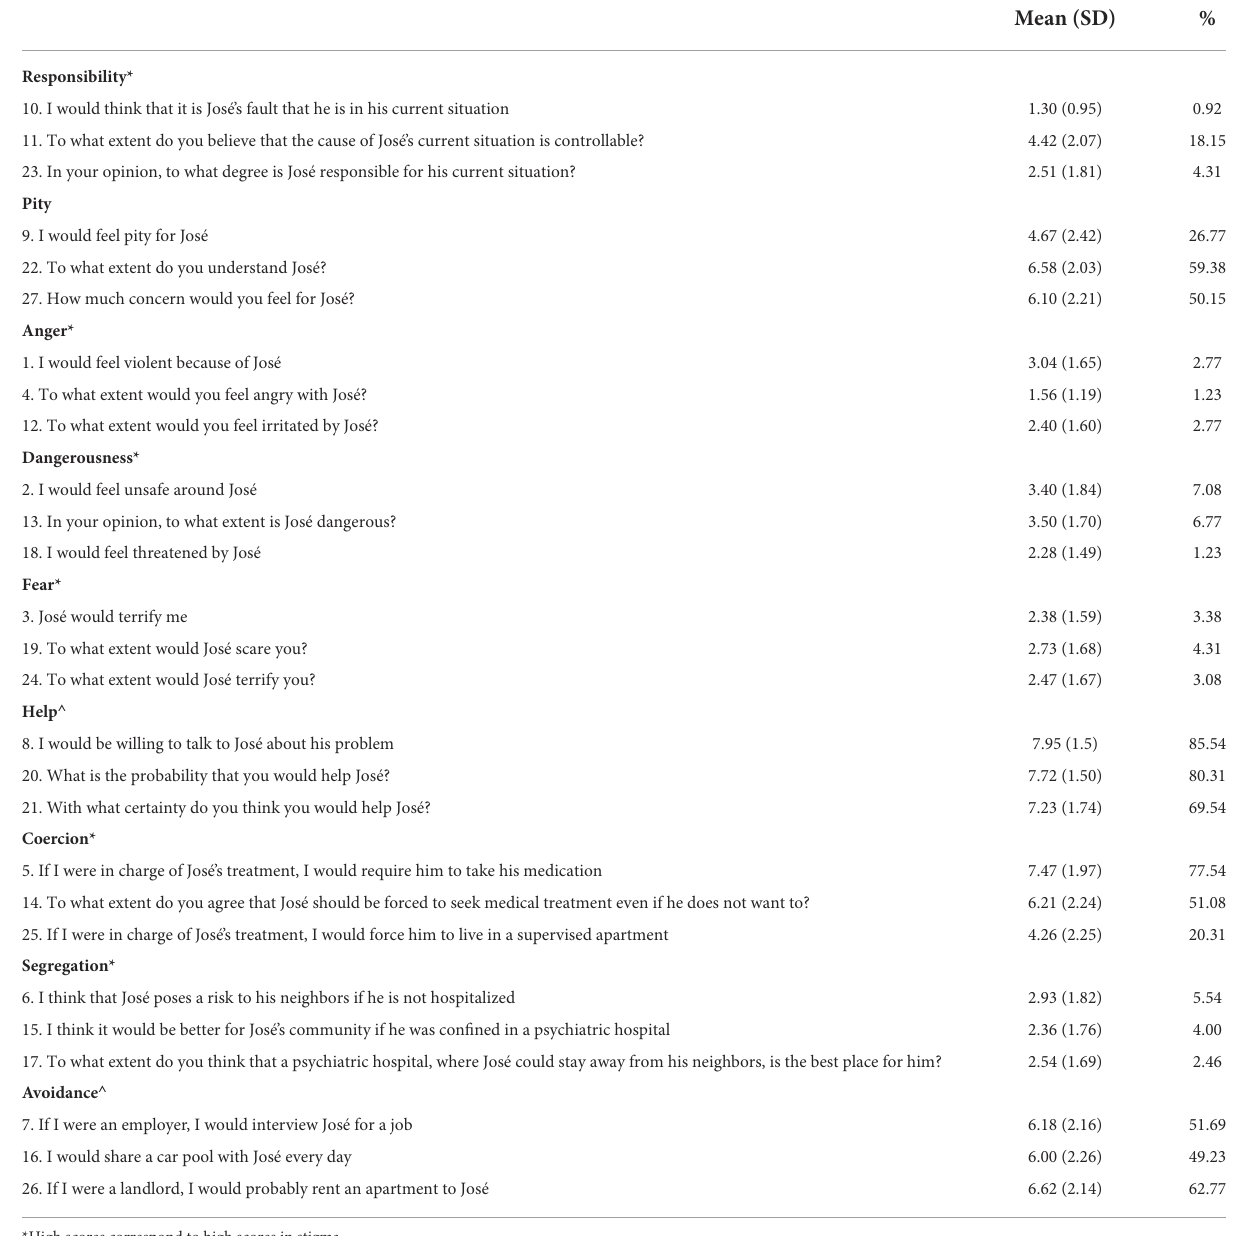
TABLE 2 Means and standard deviations of the scores for each item and percentage of participants that agree with the statement (percentage of participants that score 7, 8 or 9 in the item) in each AQ-27 item ( n = 325).